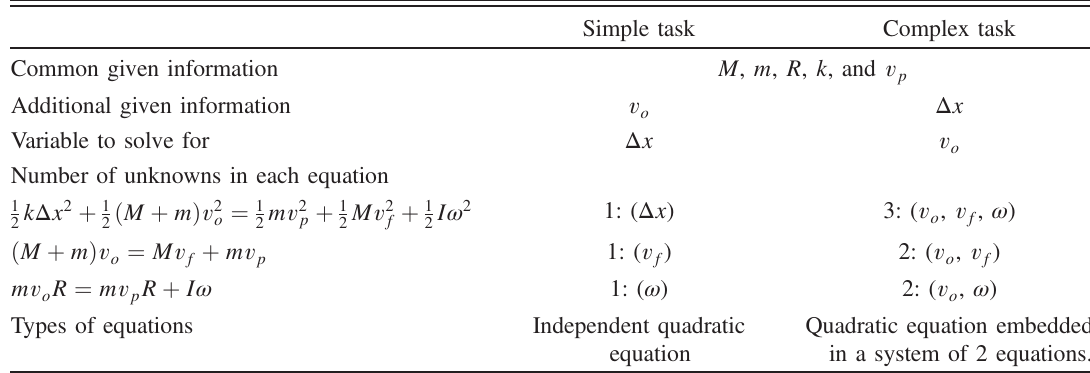
TABLE II. Known and unknown variables and types of equations across simultaneous synthesis tasks with increasing mathematical complexity ( M : mass of disc, R : radius of disc, v of disc, ω : angular velocity of disc, m : mass of projectile, v Δ x : initial compression of